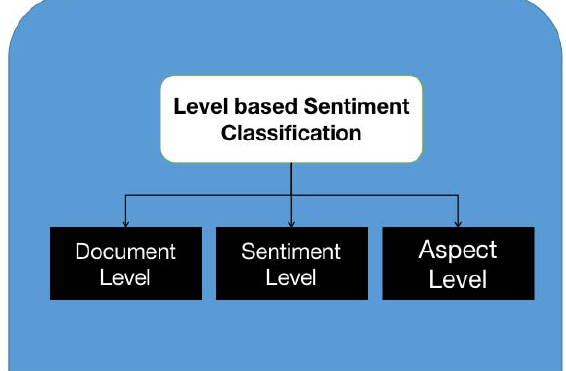
Fig. 2. Types of sentiment